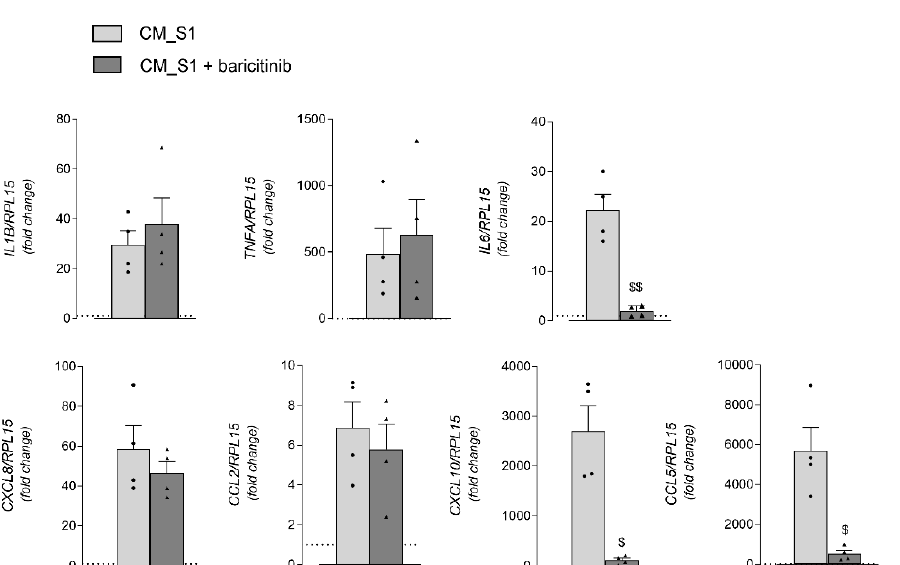
Figure 6. HUVECs were incubated for 4 h as described in Figure 5. The expression of the indicated genes was measured by means of RT-qPCR and calculated relatively to CM_cont (=1; dotted line) upon normalization for the housekeeping gene RPL15 , by employing the 2 ∆ Ct method. Bars are means ± SEM of four experiments (single dots), each performed in duplicate. $ p < 0.05, $$ p < 0.01 vs. S1-treated cells with with Student’s t